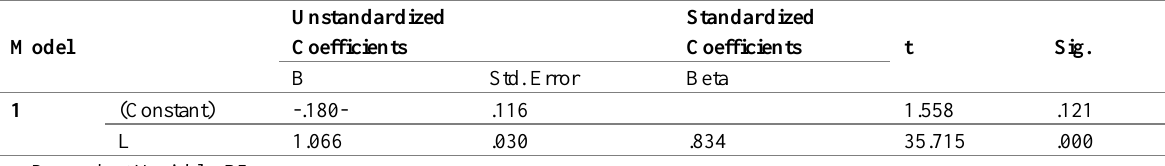
Table 14: Results of Linear Regression between Legal and Purchase Intention21